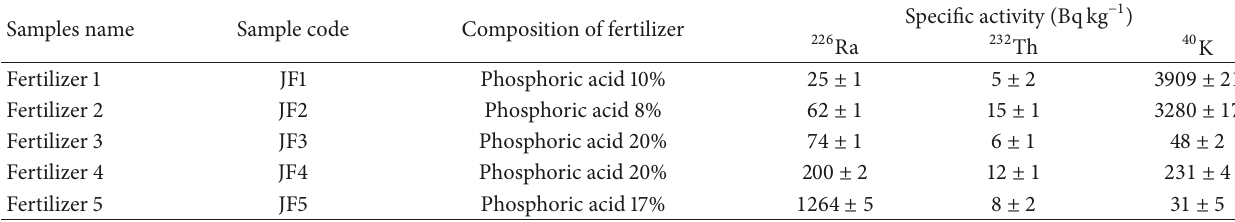
Table 2: Activity concentrations of 226 Ra, 232 Th, and 40 K in Japanese